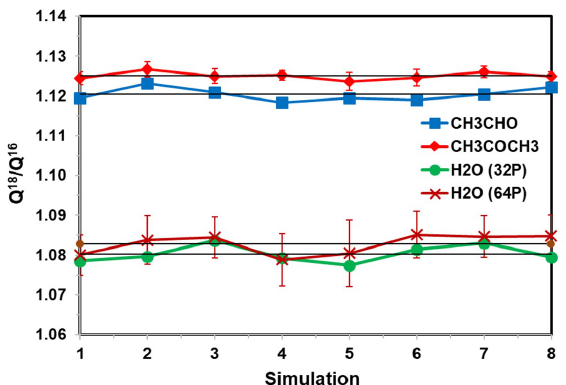
Figure 4. Computed 18 O/ 16 O equilibrium isotope fractionation for water, acetaldehyde, and acetone in water from eight sequential separate averages, in which the solvent configurations (outer average of Equation (18)) are saved ranging from every 1 to 100 time steps. For each configuration generated from Newtonian molecular dynamics at 25 °C and 1 atm, free-particle path-integral simulations are carried out to sample 210 random closed paths, of which the first 10 are discarded. For each block, 1000 configurations are included. Thus, each point in the figure corresponds to a FPPI averaging over 200,000 paths. 32 quasi-particles for acetaldehyde and acetone and 64 beads are used to represent each discretized path. The error bars for each point are estimated from 10 separate block-averages; those for acetaldehyde are smaller than the size of the symbols displayed, whereas those for water from 32-bead simulation are not shown for similarity to 64-bead. The fluctuations of the block averages mainly feature solvent configuration fluctuations.